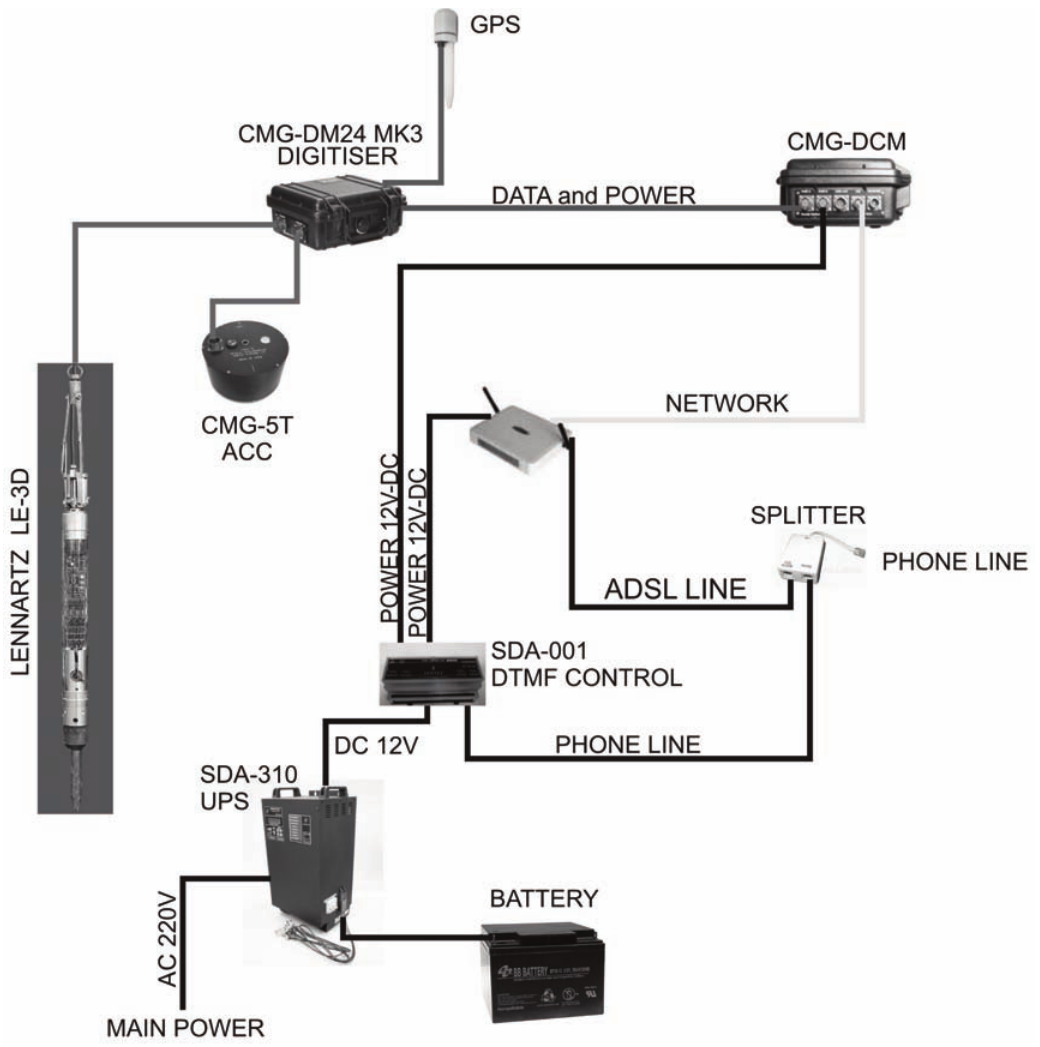
Figure 4. A sample installation chart of the borehole seismometer in Ciftlik station